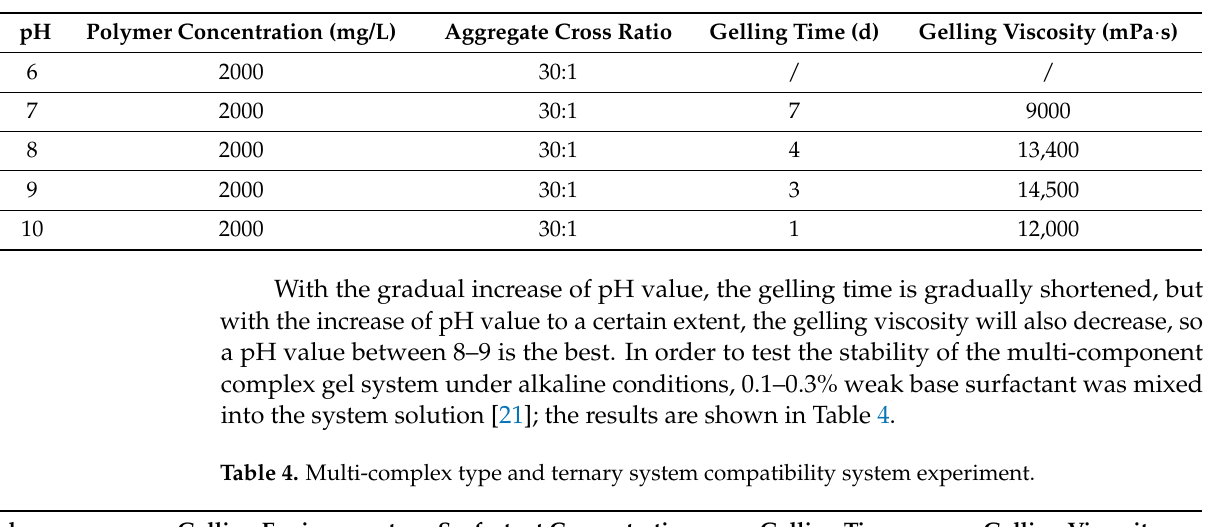
Figure 4. Polymer gelling performance curve. ( a ) The relationship curve of polymer concentration, gel time and gel viscosity. ( b ) The relationship curve of poly–cross ratio, gel time and gel viscosity. Table 3. The effect of pH on gel formation.